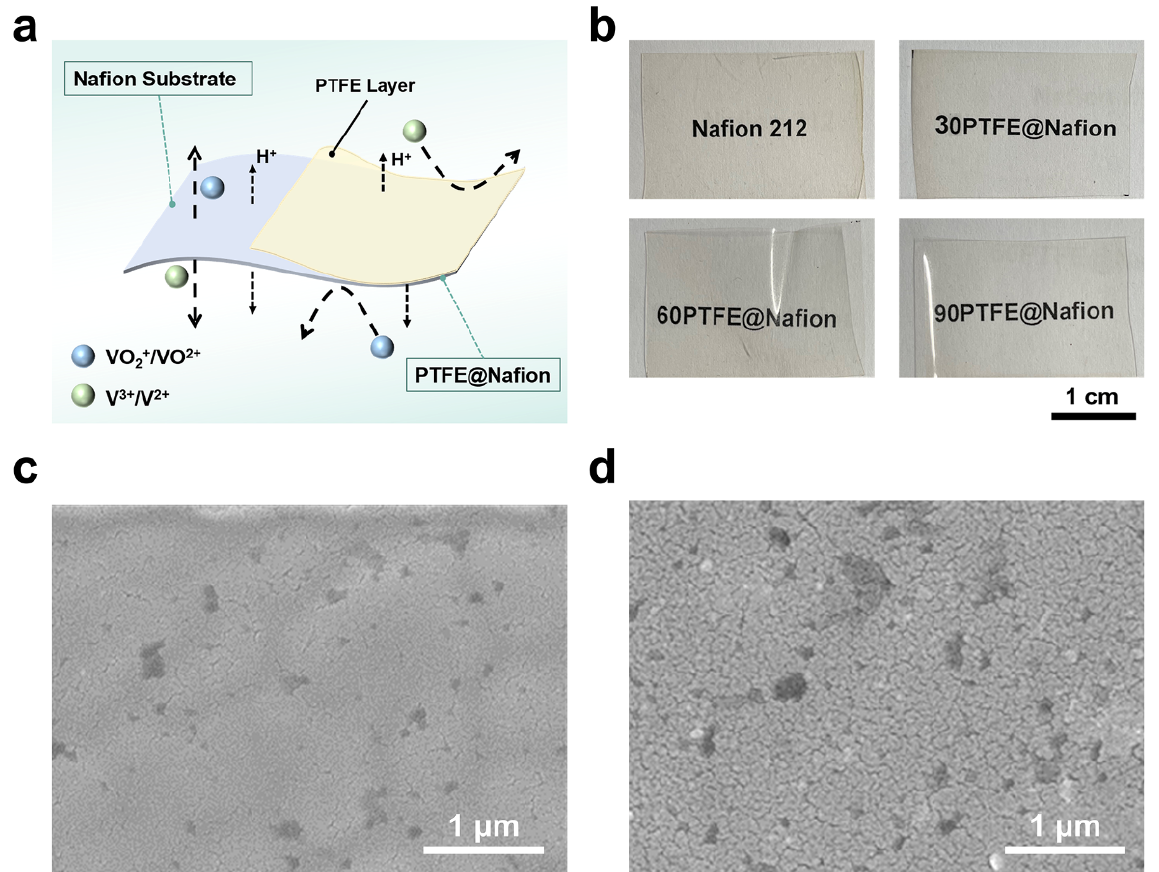
Figure 2. Morphologies of sputtered PTFE films. ( a ) Schematic illustration of a composite membrane and its influence on ion permeation, ( b ) photographs of different membranes, and top-view FESEM images of Nafion 212 ( c ) and 60PTFE@Nafion composite membrane ( d ). The dark contaminants in ( c ) and ( d ) are induced by gold sputtering to facilitate FESEM characterization.